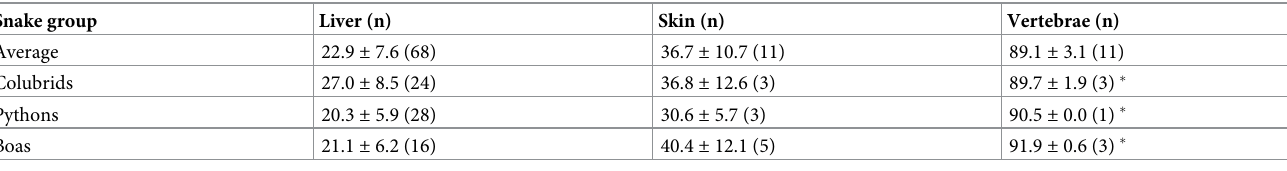
Table 2. Dry matter (% wet weight) in different body parts on average of all snakes and in relation to species (all values means ± SD; n = number of samples). Snake group